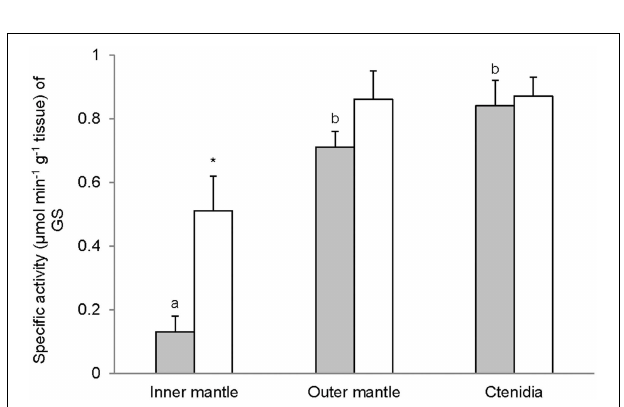
FIGURE 7 | Mass-specific activity ( µ mol Pi min − 1 g − 1 tissue) of glutamine synthetase (GS) from the inner mantle, the outer mantle, and ctenidia of Tridacna squamosa exposed to 12h of darkness (control; closed bar) or 12h of light (open bar). Values represent means + S.E.M. ( N = 4 ). Means not sharing the same letter (a, b) are significantly different from each other ( P < 0 . 05 ). ∗ Significantly different from the control ( P < 0 . 05 ).